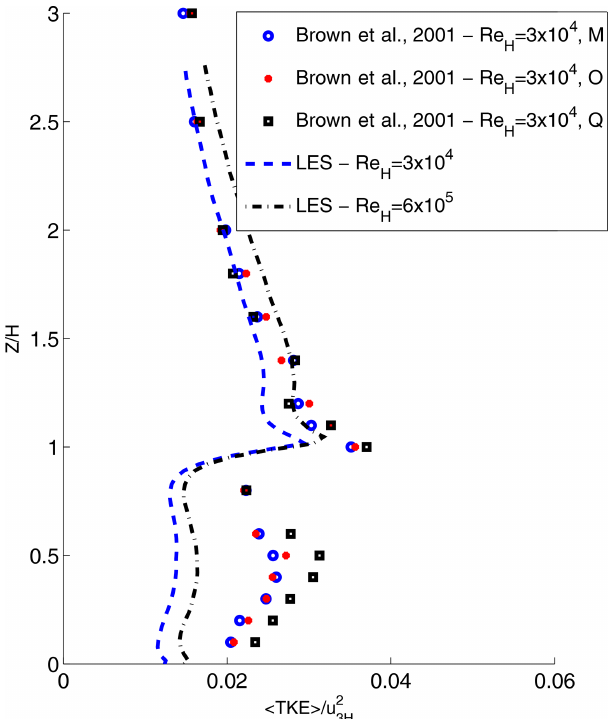
Figure 4. Comparison of the TKE profile at the center of the canyon with experimental results of Brown et al. (2001) for a 3-D building array with aligned configuration (11 × 7 obstacles). The aspect ratio of the wind tunnel experiment and numerical simulations are set to 1 ( H/W = 1), resulting in the skimming flow regime (Oke, 2002). The domain height in the numerical simulations was set to 8 H to be compatible with the experimental setup as well as the numerical results of Santiago et al. (2007). Vertical profiles along the center line of the last three street canyons (indicated by M, O, and Q here) are compared with the ensemble-averaged canyon in the LES sim- ulations. More information regarding the experiment configuration and comparison with numerical results can be found in Brown et al. (2001) and Santiago et al.